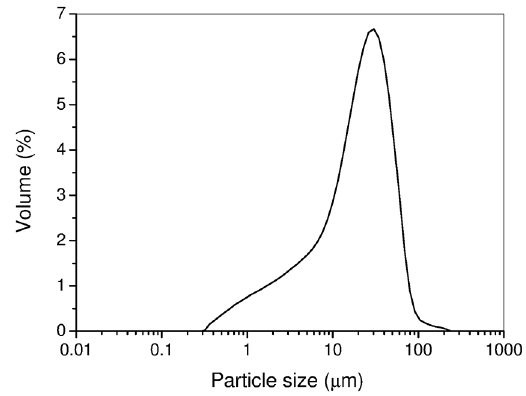
Figure 3: Particle size distribution plot for zinc tungstate prepared by the solvo-hydrothermal route. powders prepared by solvo/ 4 reference 4